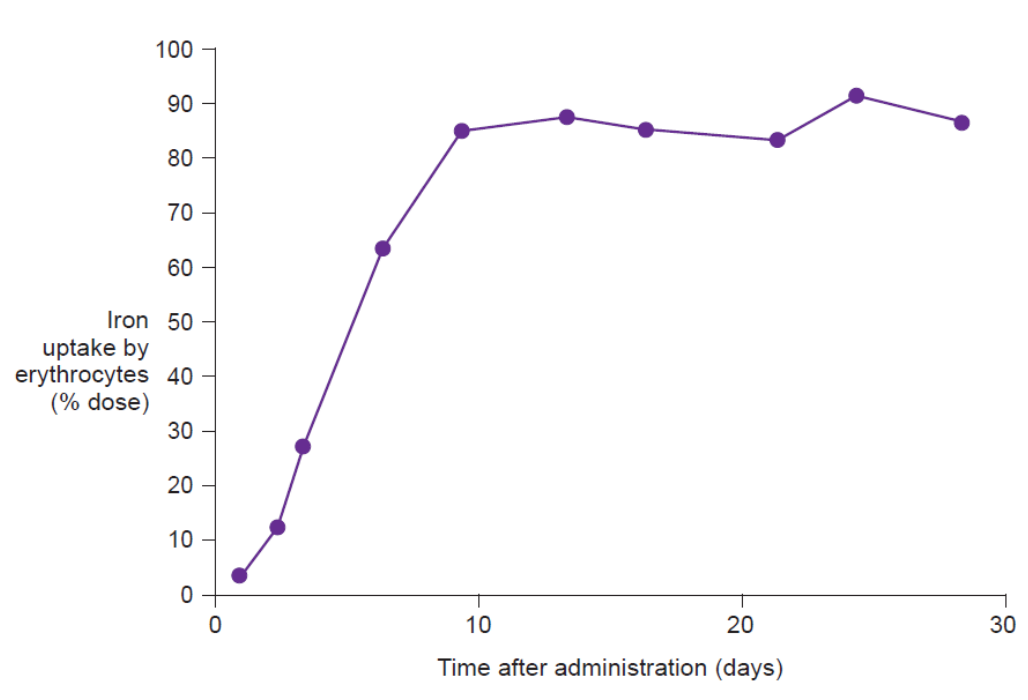
Figure 6. Utilization of iron following a single intravenous administration of radiolabeled iron sucrose (Venofer ® ) in a patient with iron deficiency anemia (modified from Beshara et al. 1999